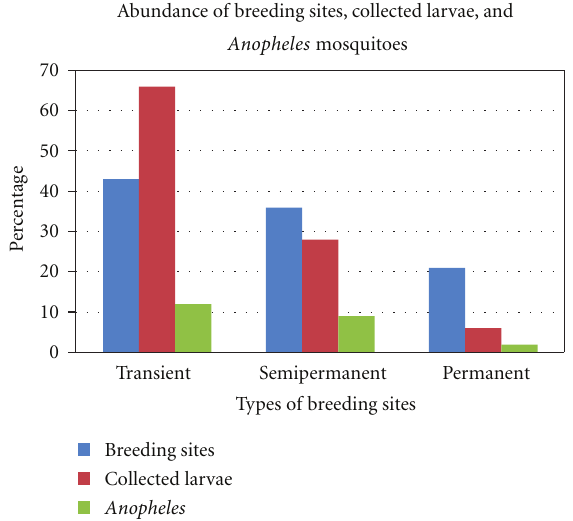
Figure 2: Abundance of breeding sites, collected larvae, and Anopheles mosquitoes.